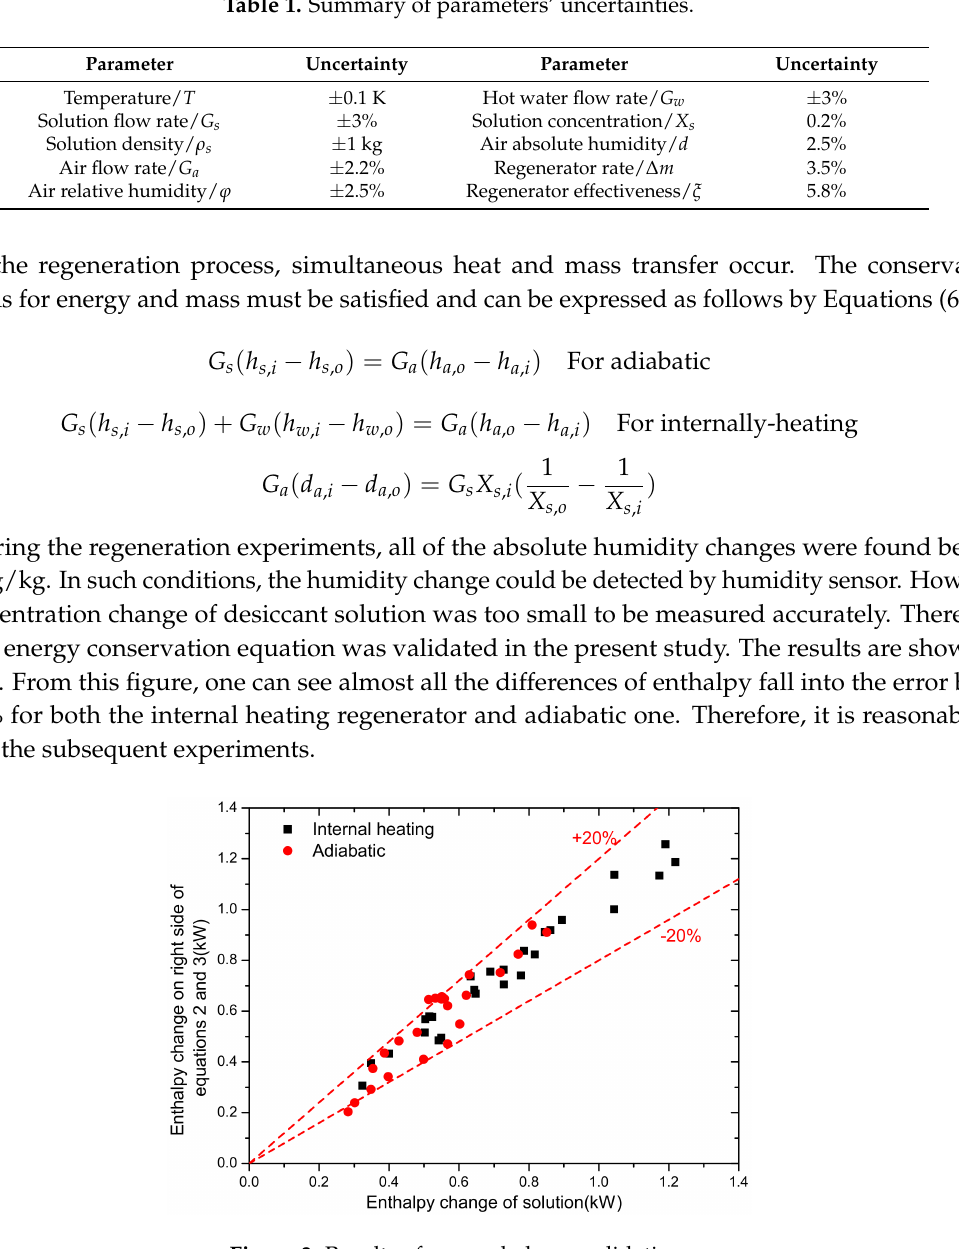
Figure 3. Results of energy balance